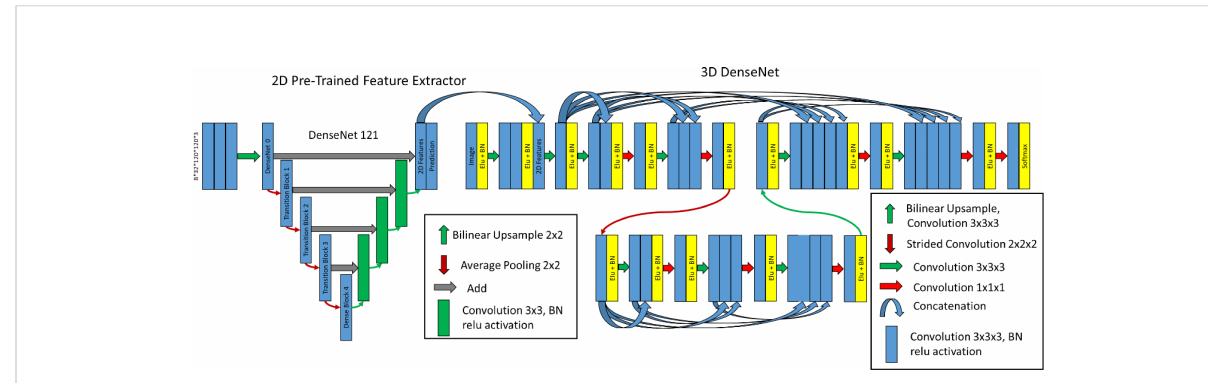
FIGURE 3 Hybrid-WNet. (Left) Pre-trained 2D DenseNet 121 converted into UNet, where fi nal features, fi lters from 2D prediction, are 32 and concatenated into 3D DenseNet. (Right) 3D DenseNet architecture was de fi ned as two layers, two convolution blocks in layer 0, three convolution blocks in layer 1, and eight initial fi lters. BN, batch normalization.